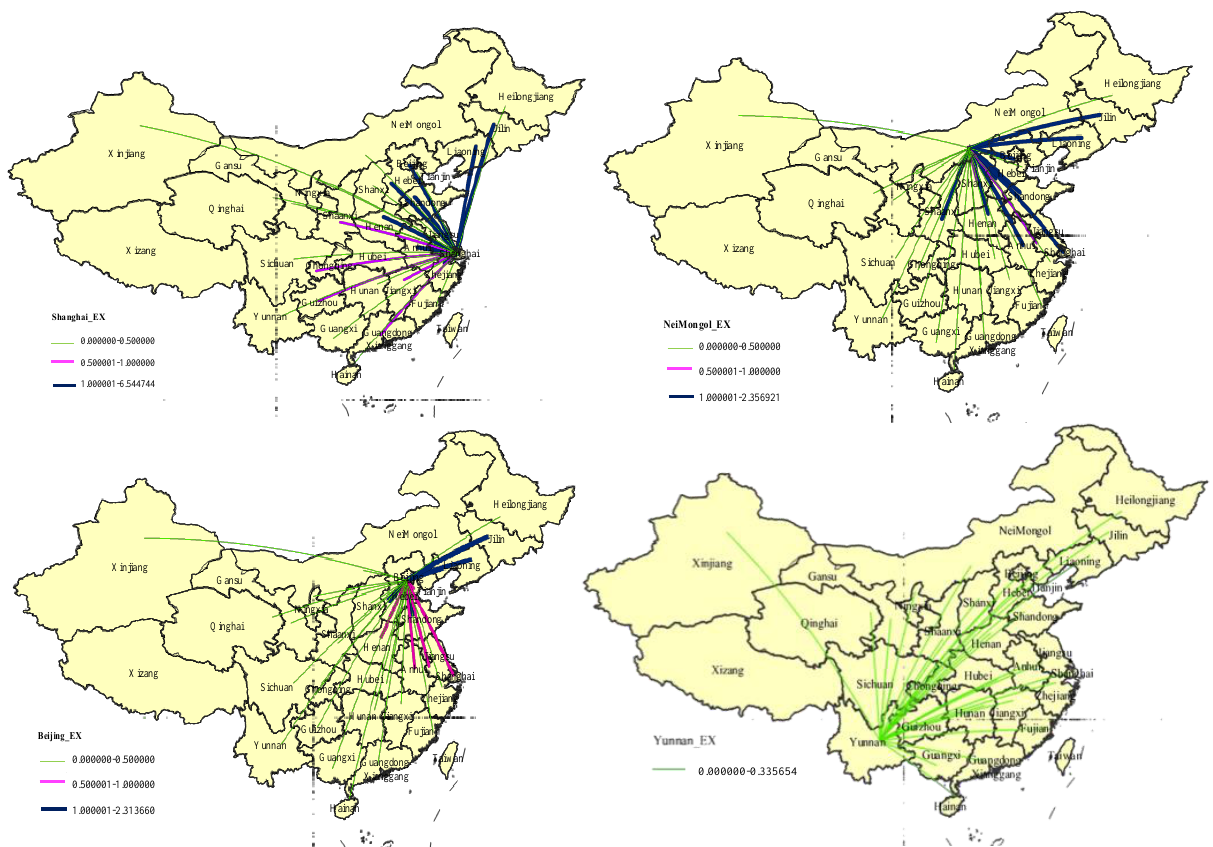
Figure 6. Spatial distribution of energy use embodied in the transport sector exports of the top four provinces in 2012. The sources of the embodied energy inflows of the TS in the top four provinces are illustrated in Figure 7. For Shanghai, the biggest energy inflows embodied in the TS’s imports are from Inner Mongolia, Zhejiang, Hebei, and Beijing. They provide 38.2% of the total. For Jiangsu province, Shanghai, Inner Mongolia, Anhui, and Hebei are its major energy suppliers, which occupy 60.23% of the total energy embodied in its TS’s import. As for Hebei, the EU embodied in its imports of the TS mainly comes from Beijing with 0.785 Mtce, Inner Mongolia with 0.742 Mtce, Shanxi with 0.681 Mtce, and Shanghai with 0.493 Mtce, which account for 57.15% of the total. In Liaoning, most of the embodied energy of the TS’s imports is mainly from Shanghai with 0.292 Mtce, Hebei with 0.271 Mtce, Inner Mongolia with 0.254 Mtce, and Beijing with 0.204 Mtce, which constitute 45% of the total energy input. Based on the above results, the top four provinces interact more frequently with their neighboring provinces and cities. Both Shanghai and Inner Mongolia are the major source regions for the energy embodied in the imports of the TS of the four prov- inces.